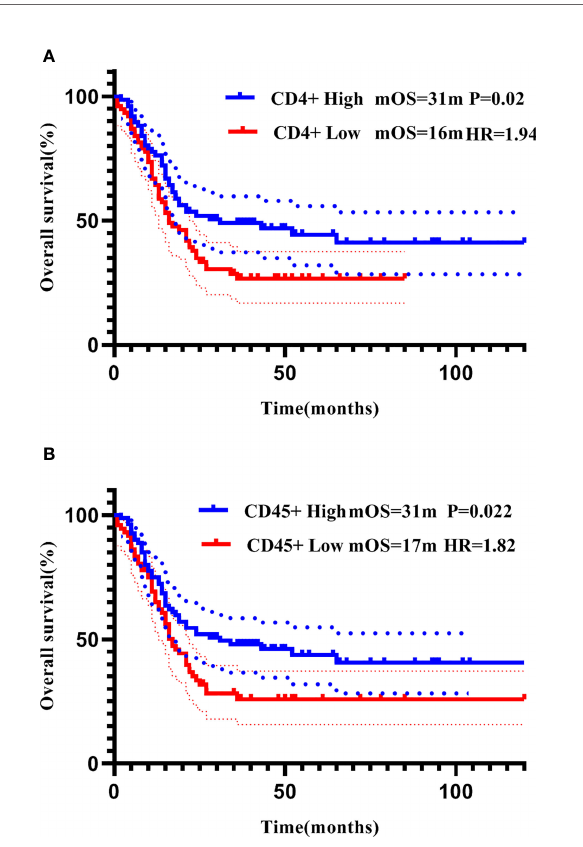
FIGURE 6 | Correlation of CD4+ (A) and CD45+ (B) with OS in patients with mTNBC addressed by the Kaplan-Meier method and log-rank